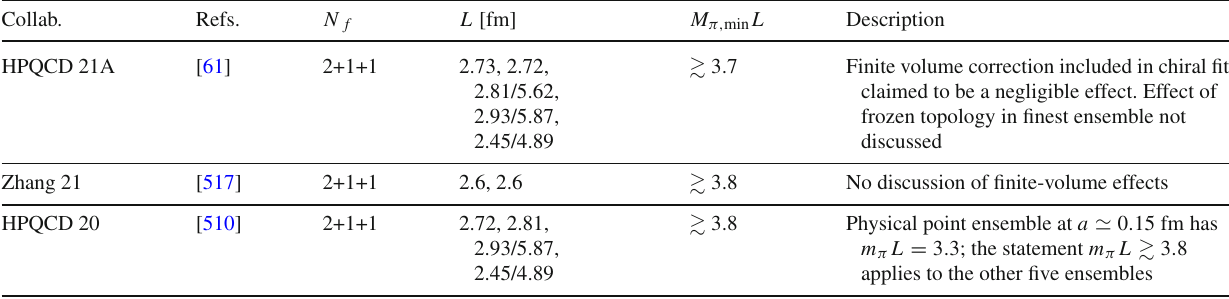
Table 137 Finite-volume effects in determinations of form factors for semileptonic decays of charmed hadrons. Each L -entry corresponds to a different lattice spacing, with multiple spatial volumes at some lattice spacings. For actions with multiple species of pions, the lightest pion masses are quoted Collab.